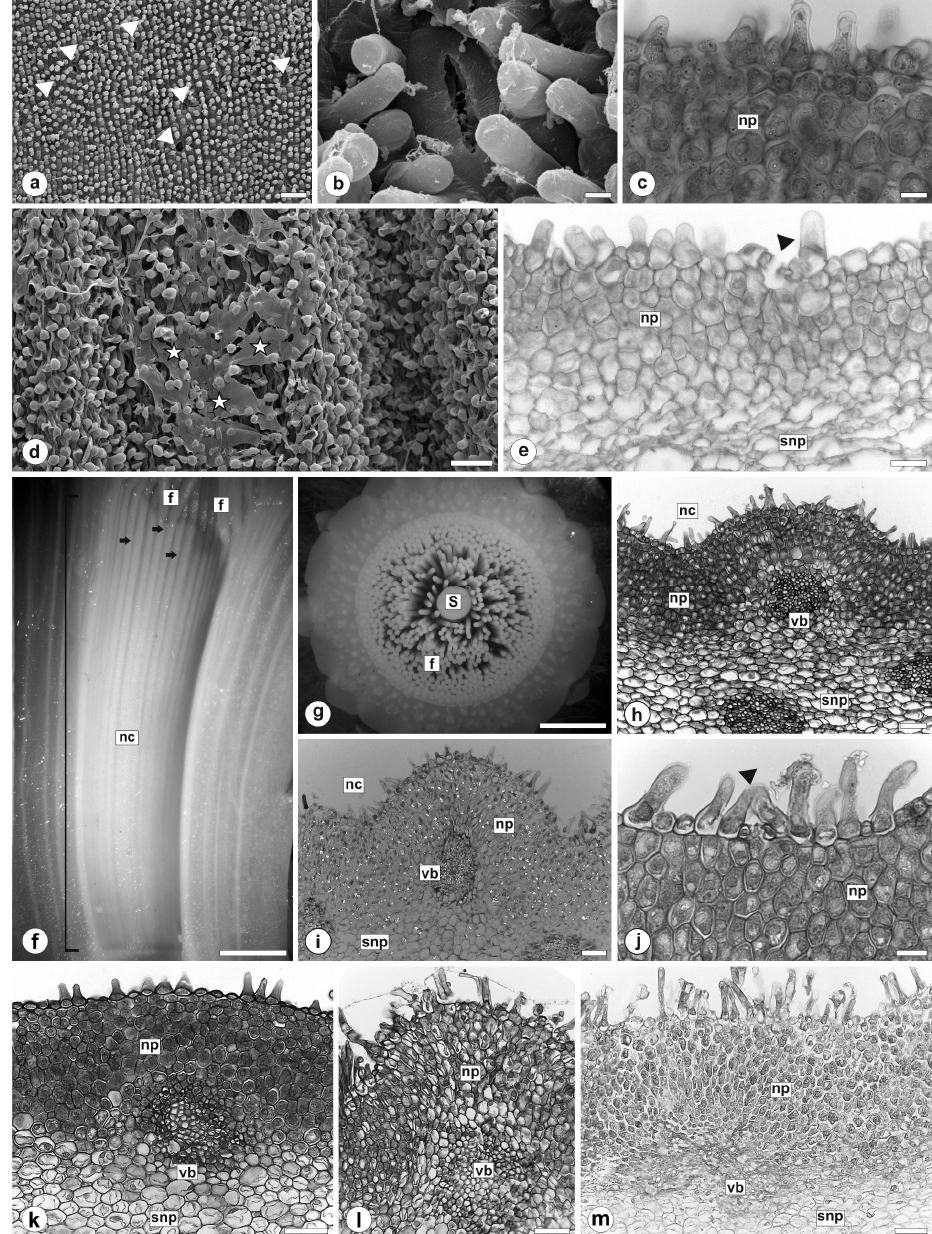
Figure 4. Floral nectary morpho-anatomy of Echinopsis. a-c E. albispinosa . a-b SEM. a Superficial view of nectar chamber wall, note nectarostomata (white arrowheads). b Detail of nectarostoma. c Light micrographs of cross section of floral nectary. d-e E. ancistrophora . d Superficial view of nectar chamber wall, note nectar secretion (white stars). e Light micrographs of cross section of floral nectary. f-j E. atacamensis . f Nectar chamber in longitudinal section, note free filaments of the internal series at the top. g Transversal section of the flower above the nectar chamber, note the barrier formed by the filaments surrounding the style. h, k-m Light micrographs of transversal sections of floral nectary. i Floral nectary with polarized light, note druses and starch grains in nectariferous parenchyma. j Detail of nectarostoma with possible secretion remains (arrowhead), observe unicellular trichomes inclined towards the opening. k E. leucantha. l E. schickendantzii. m E. terscheckii . Abbreviations: (f) filament; (nc) nectar chamber; (np) nectariferous parenchyma, (S) style, (snp) sub-nectariferous parenchyma, (vb) vascular bundles. Scales: a, d, h-i, k-m 50µm; b 5µm; c 10µm; e, j 20 µm; f 3mm, g